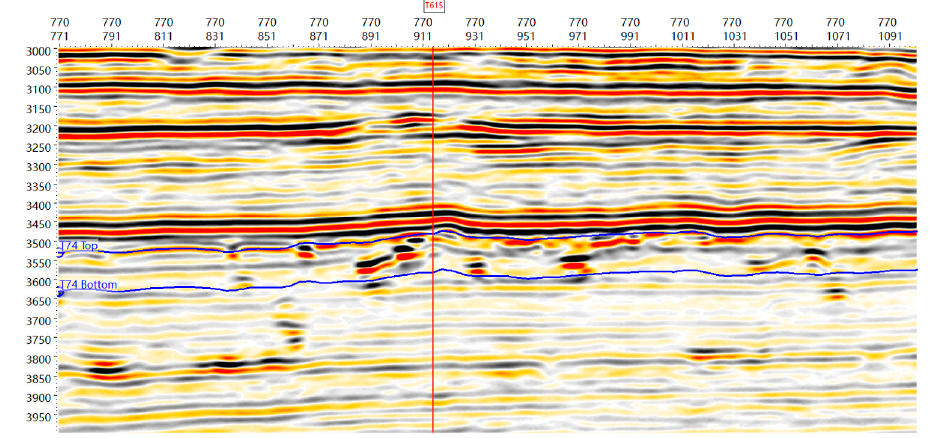
Figure 3. 2-D seismic data cross T615. The area between T74 Top and Bottom is the target reservoir.